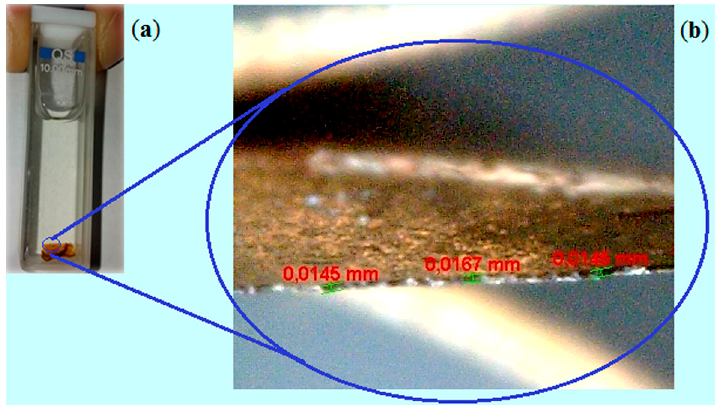
Figure 2. ( a ) Pd-IAzoCsM immersed in buffer solution (pH 4.1) of Pd(II); ( b ) optical photograph of Pd-IAzoCsM in a dried state.